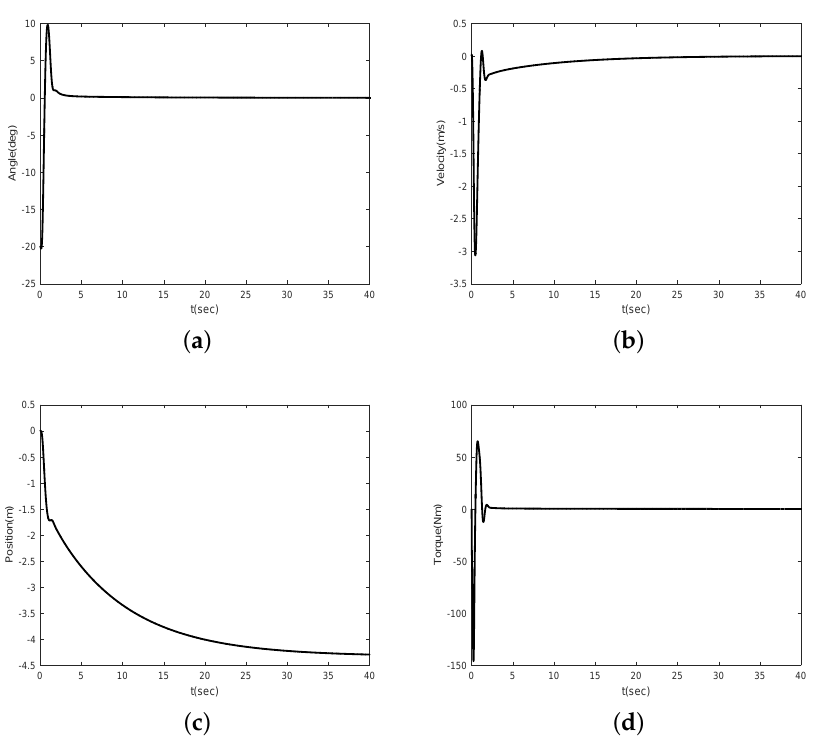
Figure 3. Simulation result for θ ( 0 ) = − 20 ◦ : ( a ) angle θ ; ( b ) linear velocity v ; ( c ) position x ; ( d ) torque τ